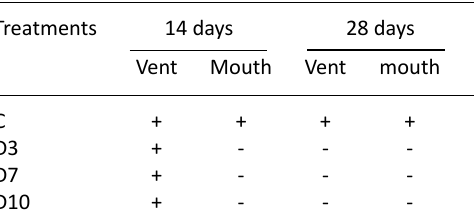
Table 3. Effects of microsafe spraying on present of E coli bacteria O157H:7 in mouth and Vent of birds in